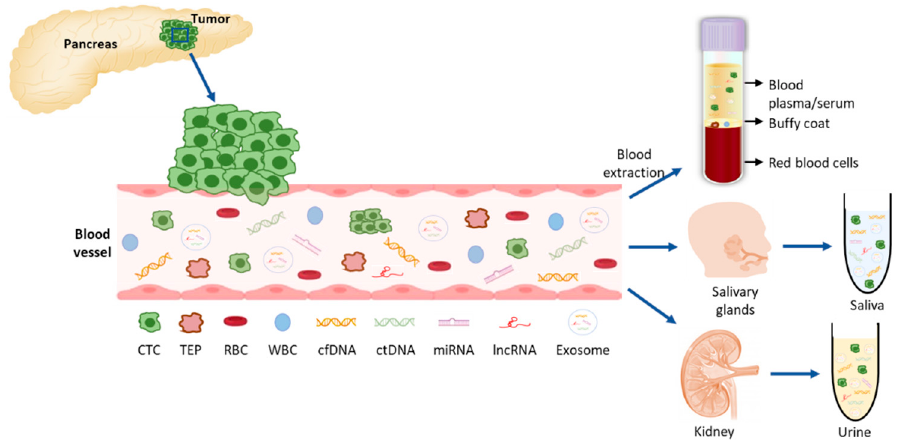
Figure 2. Liquid biopsy components in PDAC. Tumor cells (CTCs) are shedded from the tumor into the blood vessels where they can release their components: nucleic acids and exosomes with tumor-specific cargo material. For the analysis of these molecules, blood can be extracted and plasma or serum further processed for the extraction of the desired components. From the blood circulation, these molecules can be filtered to saliva and urine which can also be collected and further analyzed. CTC: circulating tumor cell; TEP: tumor educated platelet, RBC: red blood cell; WBC: white blood cell; cfDNA: cell-free DNA; ctDNA: circulating tumor DNA; miRNA: micro RNA; lncRNA: long non-coding RNA.